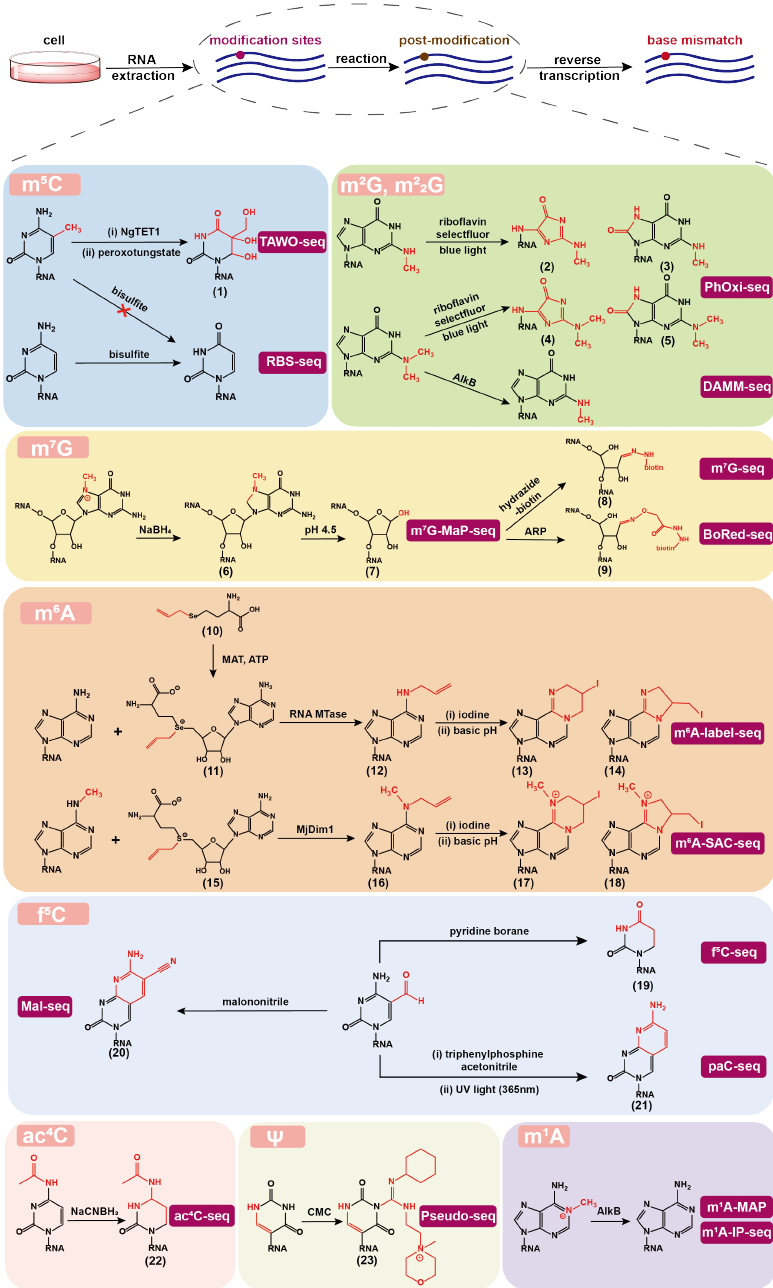
Figure 2. Various chemical or enzymatic reactions for converting natural RNA modifications into post-modified forms, which can induce base mismatch during reverse transcription of RNA into cDNA and thus can be identified at single base resolution in the corresponding high-throughput sequencing methods. TAWO-seq: TET-assisted peroxotungstate oxidation sequencing; RBS-seq: RNA bisulfite sequencing; PhOxi-seq: photo-oxidative sequencing; DAMM-seq: demethylation-assisted multiple methylation sequencing; m 7 G-MaP-seq: m 7 G mutational profiling sequencing; BoRed- seq: borohydride reduction sequencing; m 6 A-SAC-seq: m 6 A-selective allyl chemical labeling and sequencing; Mal-seq: selective malononitrile-mediated labeling and sequencing; NgTET1: Naeglaria Tet-like oxygenase; AlkB: alpha-ketoglutarate-dependent dioxygenase; ARP: N -(aminooxyacetyl)- n (cid:48) -(d-biotinoyl) hydrazine; MAT: methionine adenosyltransferase; ATP: adenosine triphosphate; RNA MTase: RNA methyltransferase; MjDim1: Methanocaldococcus jannaschii homolog; CMC: N - cyclohexyl- N (cid:48) -(2-morpholinoethyl) carbodiimide metho- p